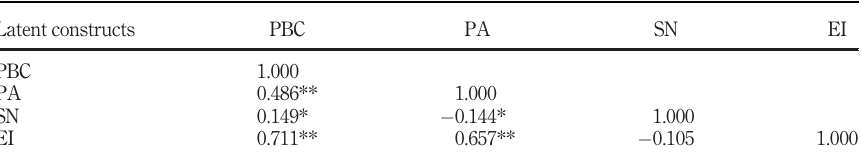
Latent constructs